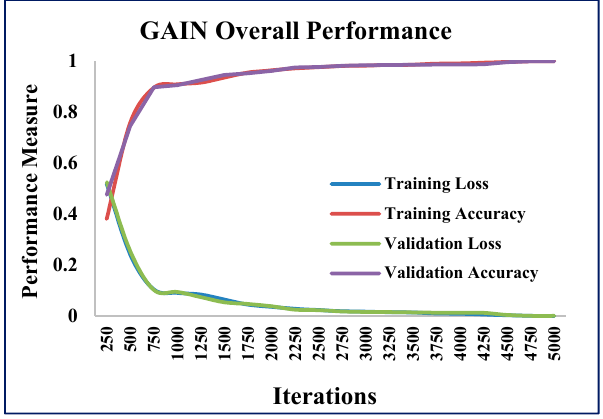
Figure 14. GAIN overall performance.